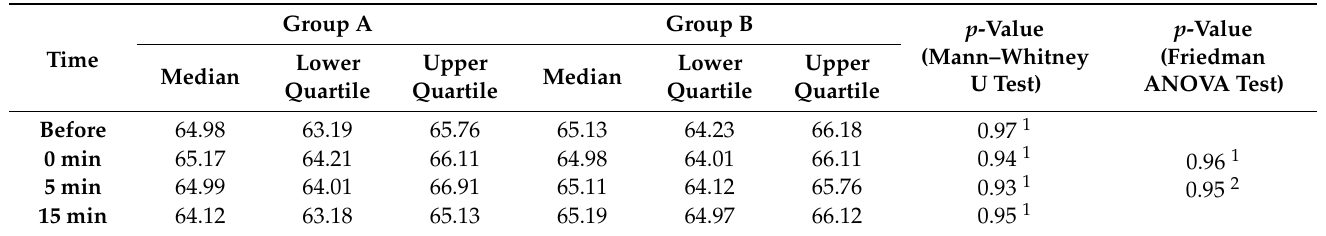
Table 4. The value of skin moisture in participant of Groups A and B at different observation